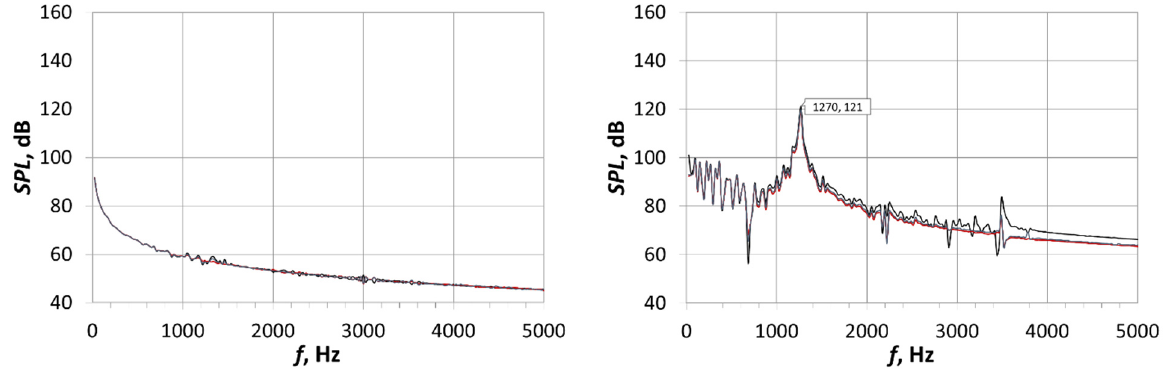
Figure 16. Spectral analysis of SPL for velocity equal to 60 m/s—CFD.